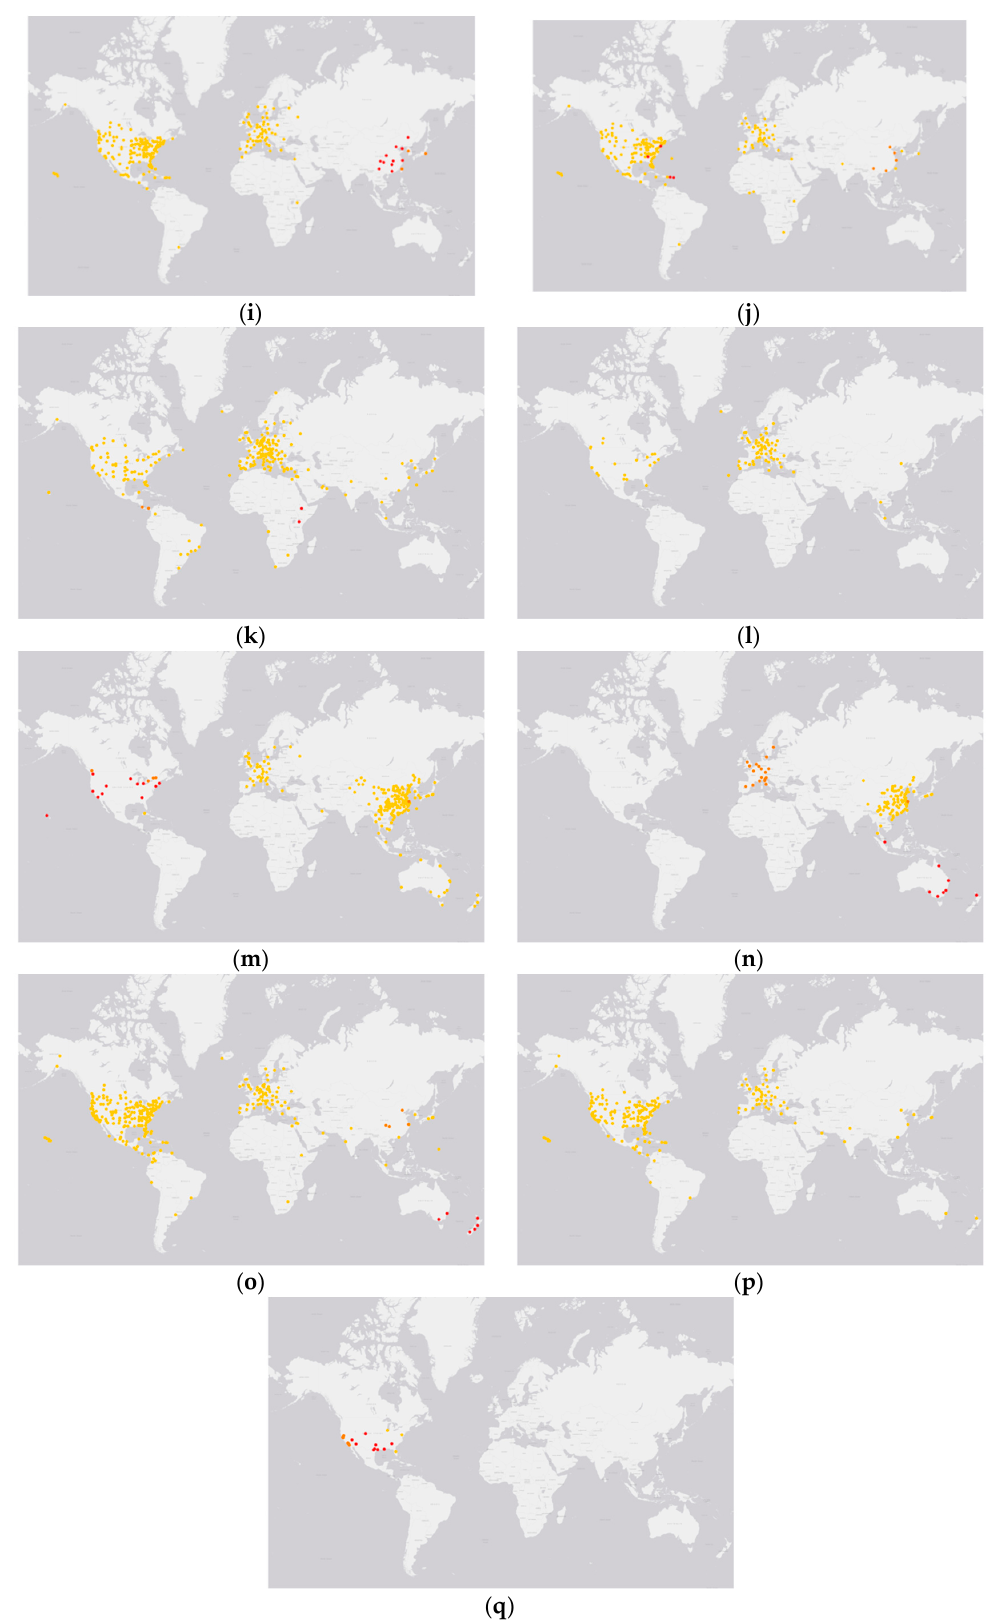
Figure 2. Stylized network extract for community detection results. ( a ) Three-clique community detection results for